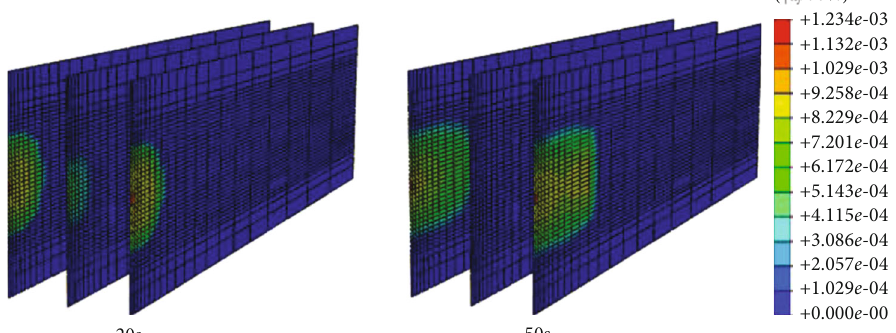
Figure 11: Fracture geometry after pumping for 20s and 50 s in case 3.